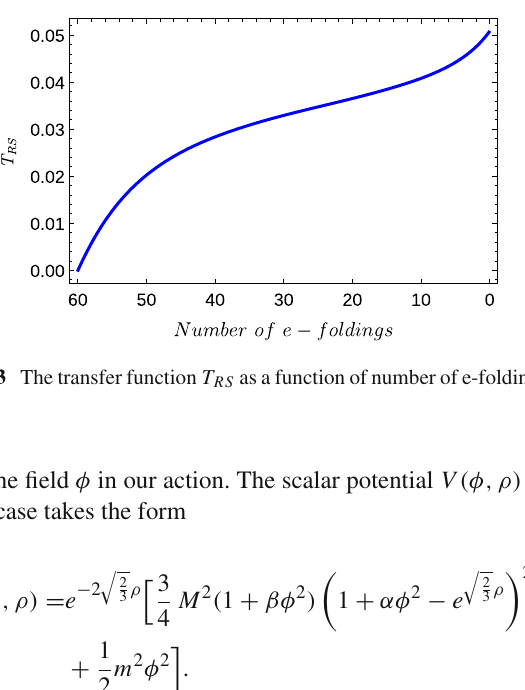
Fig. 4 Top: the Hubble parameter as a function of time. Bottom: the logarithm of the scale factor a ( t ) . With the black line is denoted the time of the last 60 e-folds before the end of inflation